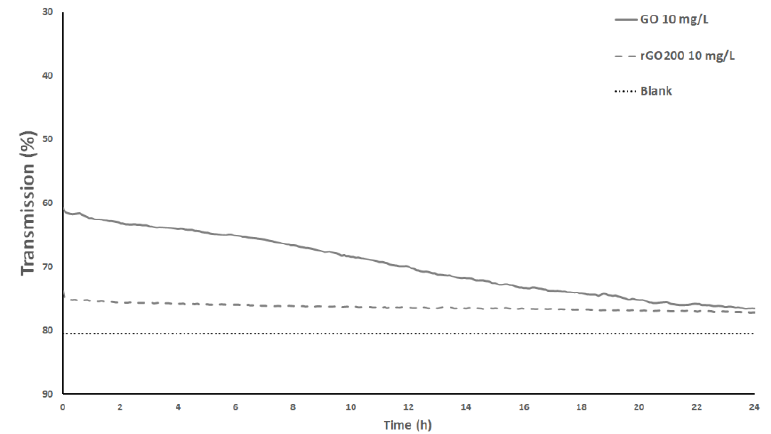
Figure 3. Monitoring of the stability of GO and rGO200 dispersion in the water column of exposure medium over 24 h (in absence of Xenopus larvae), expressed by the percentage of transmission detected after the light goes through the sample. Blank: medium without nanoparticles.